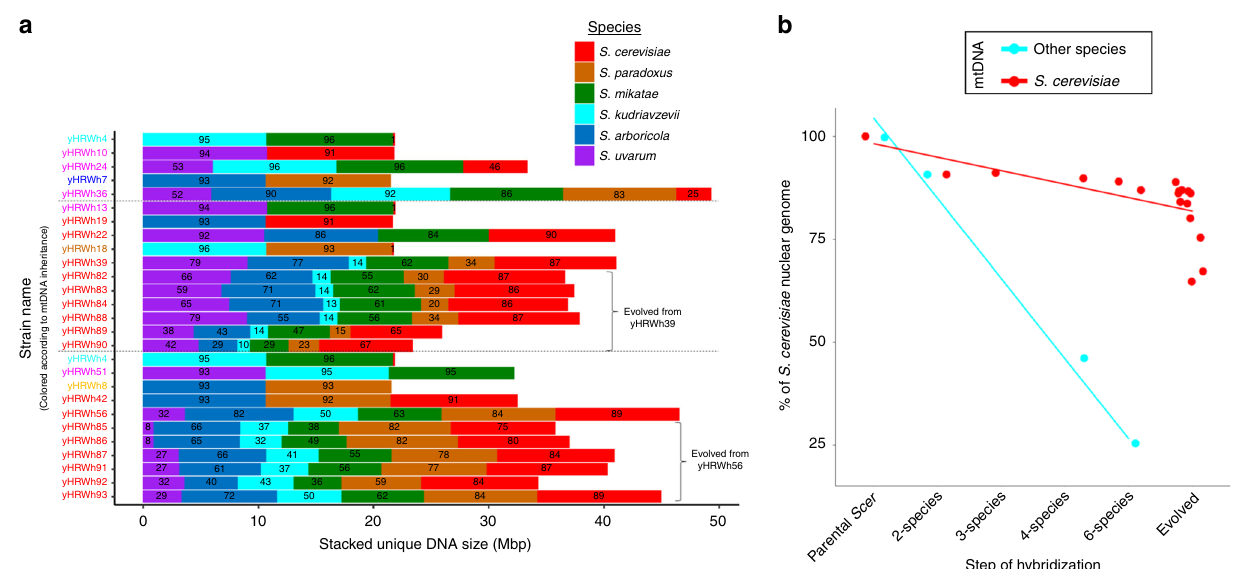
Fig. 4 Genome reduction during hybrid construction and adaptive laboratory evolution. a The genome contribution of each Saccharomyces species is stacked, and the percentage of retention is indicated inside the bar plot for each synthetic hybrid. Presence is reported, not copy number. For example, the red stacked bar for the hybrid yHRWh24 indicates that 46% of the total unique DNA for the S. cerevisiae parent (12.07 Mbp) was detected in the hybrid, which is ~5.55 Mbp of unique DNA. Synthetic hybrids are displayed in the order constructed (Supplementary Fig. 2). yHRWh4 is shown multiple times because of its use in two crossing schemes. We did not expect 100% genome contribution for each Saccharomyces species, even for recently created hybrids, because some genomic regions (e.g. repeats) are not unambiguously detectable with Illumina sequencing data. Genome size bars are colored according to each species ’ contribution. The strain names are colored based on the mtDNA inheritance inferred from mitosppIDer (Supplementary Fig. 4), with two or more mtDNAs or regions shown as a gradient. b The nuclear compositions of the S. cerevisiae parent, synthetic hybrids, and evolved hybrids are plotted according to mtDNA inheritance ( n = 1 sequenced strain). Hybrids with S. cerevisiae mtDNA or with other mtDNA are colored in red and light blue, respectively. Source data are in the Source Data fi le and at http://bit.ly/2v1rq1T.